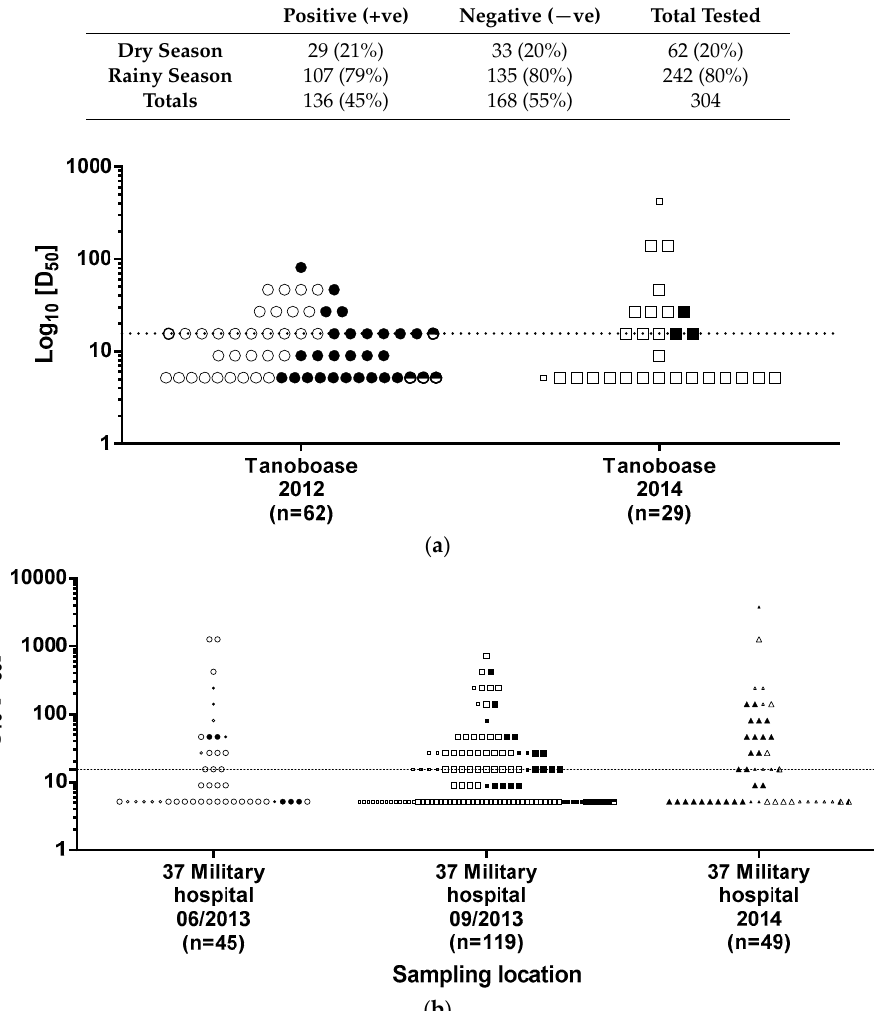
Figure 2. Serological profiles of straw-colored fruit bats sampled at ( a ) Tanoboase in the Brong-Ahafo region and ( b ) at 37-Military Hospital, Greater Accra. Open symbols represent male bats, closed symbols represent female bats; half-filled symbols represent bats of undetermined sex. Smaller symbols represent juvenile or sub-adult bats. The D 50 value considered the cut-off for positivity is indicated by a dashed line.